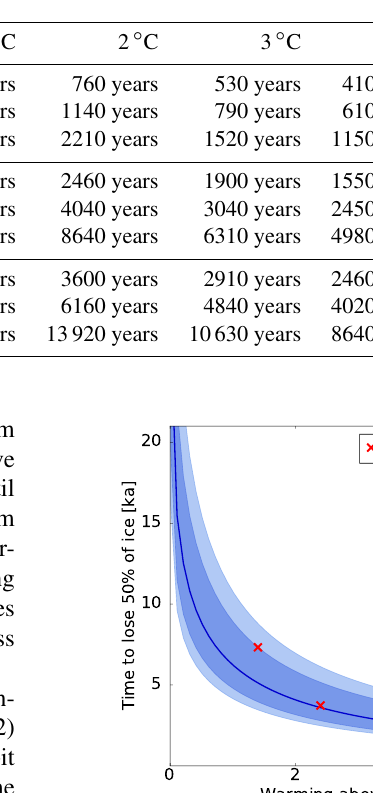
Table 1. Decay time. Time period after which different percentages of volume loss have occurred at different warming levels. Provided are the median values of the distributions from Figs. 2 and 3 together with the lower and upper limits that are derived respectively from the upper and lower limits of the uncertainty range of the observed melting sensitivity and atmospheric lapse rate. The simple decay time equation (Eq. 17) does not take any ice dynamic effects into account and its translation to ice volume assumes a constant horizontal ice sheet area. Thus the values provided here best fit the complex model simulations only when these assumptions are reasonably well justified, which is most likely not the case for high ice loss such as 50 or 100% of the original ice volume.